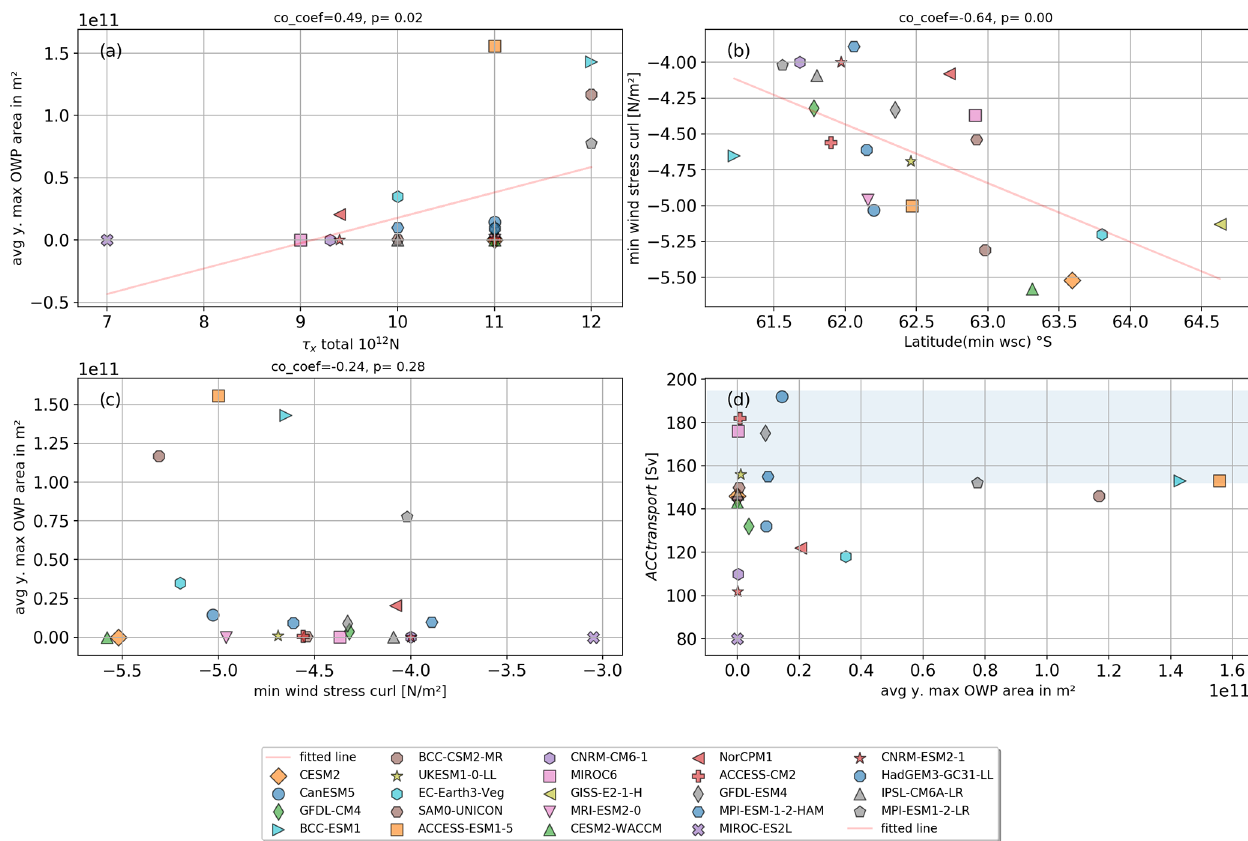
Figure 11. Connection of yearly OWP area (as in Eq. 2) with CMIP6 Southern Ocean properties from (Beadling et al., 2020). Total zonally averaged Southern Ocean wind forcing ( x ) and averaged OWP area ( y ) (a) , linear regression plot of the maximum zonally integrated wind stress curl for each CMIP6 model and the latitude of that maximum (b) , wind stress curl minimum ( x ) and OWP area ( y ) (c) , and OWP area vs. ACC transport (d)